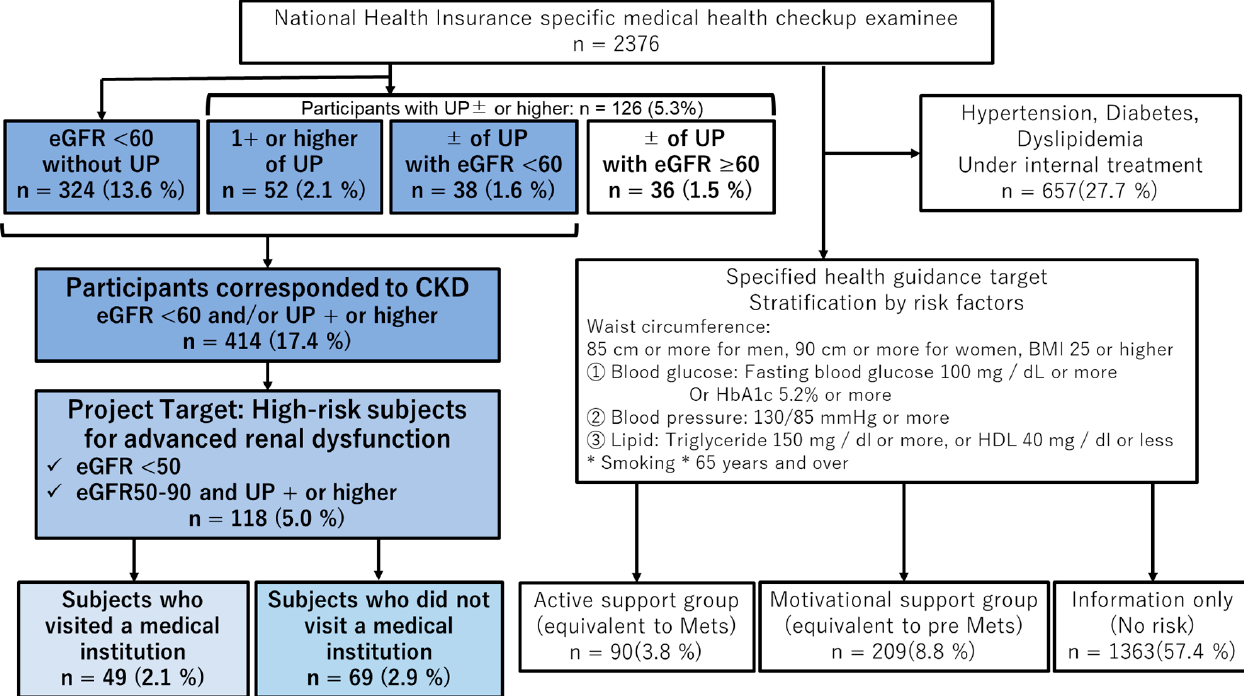
Figure 2. Changes in the number of high-risk subjects for advanced renal dysfunction. The orange bar shows the number of high-risk subjects in each year. 3.2. The Parameter Changes in High-Risk Subjects for Advanced Renal Dysfunction Comparing the various parameters of 63 subjects, who accomplished the follow-up to 2017, between 2013 and 2017 (Table 2), the significant changes were confirmed in the serum levels of HDL-C, creatinine, and urinary protein by paired t -test or Chi-square test. Regarding the lipid profile, HDL-C was slightly worsened with a significant difference, however LDL-C was improved although there was no significant difference. There was